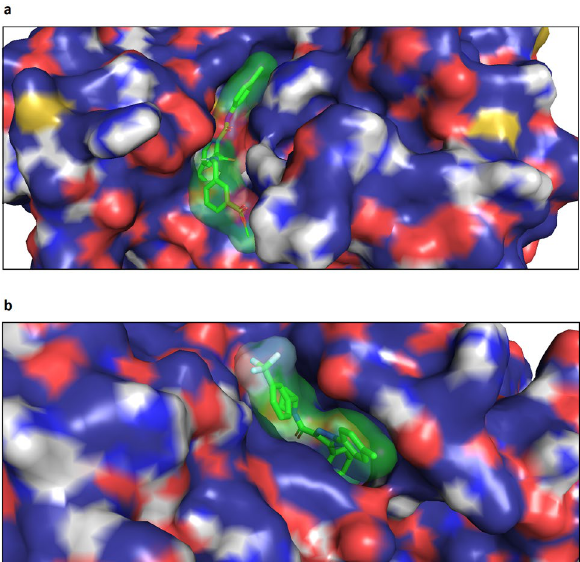
Figure 4. Positions of the generated molecules with the lowest scores in the binding sites of the following proteins: ( a ) Insulin-like growth factor 1 receptor, ( b ) Vascular endothelial growth factor receptor